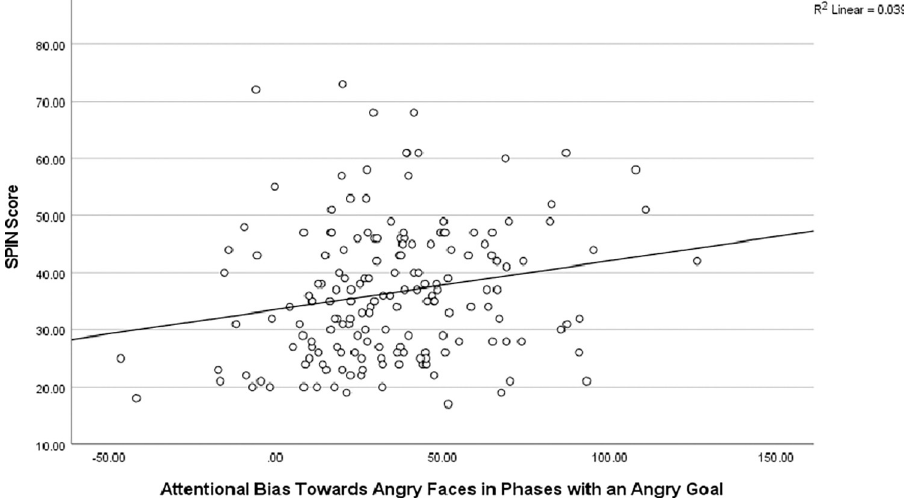
Fig 4. Association between social anxiety and attention to angry faces. Scatterplot showing the association between the SPIN score (y-axis) and attention bias to angry faces across the trials showing angry faces (in ms, x-axis) in the phases where angry phases were goal